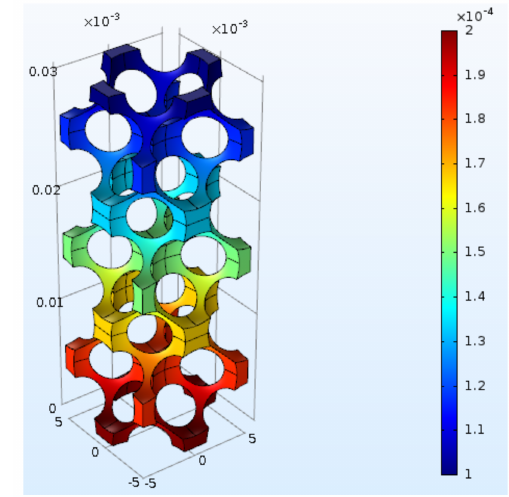
Figure 9. Example of concentration gradient obtained as a solution of the simulation performed for the overlapping FCC